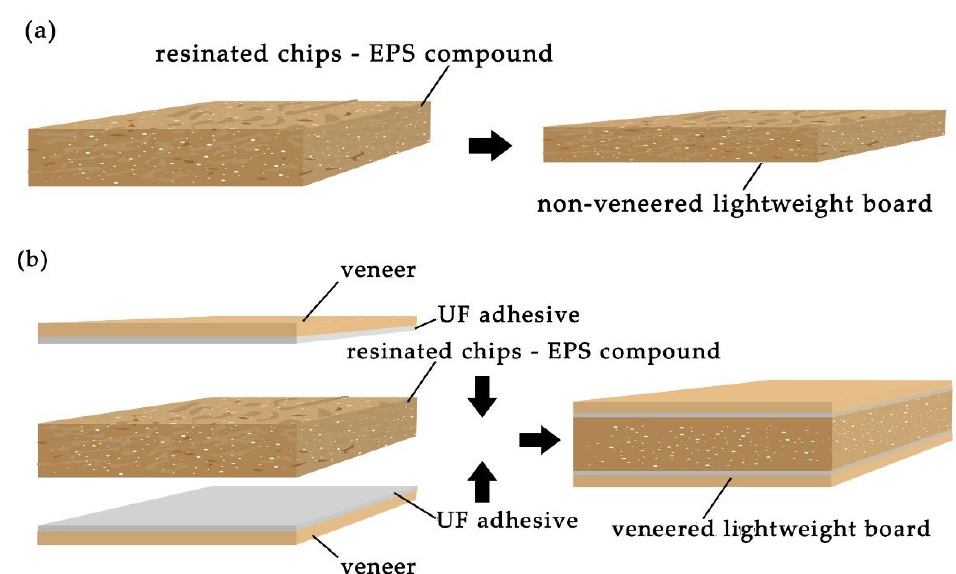
Figure 2. Structure of non-veneered ( a ) and veneered ( b ) lightweight particleboards.